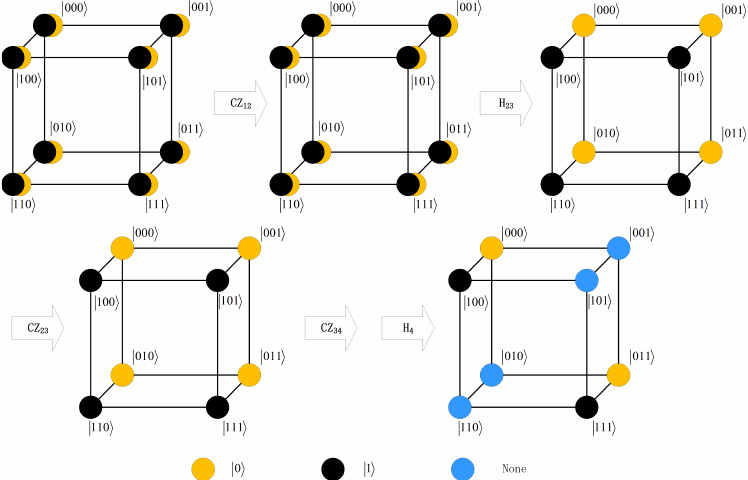
Figure 9. Generating 4-qubit cluster state using single particle quantum walk, where yellow circles represent | 0 (cid:105) , black circles represent | 1 (cid:105) , and blue circles represent